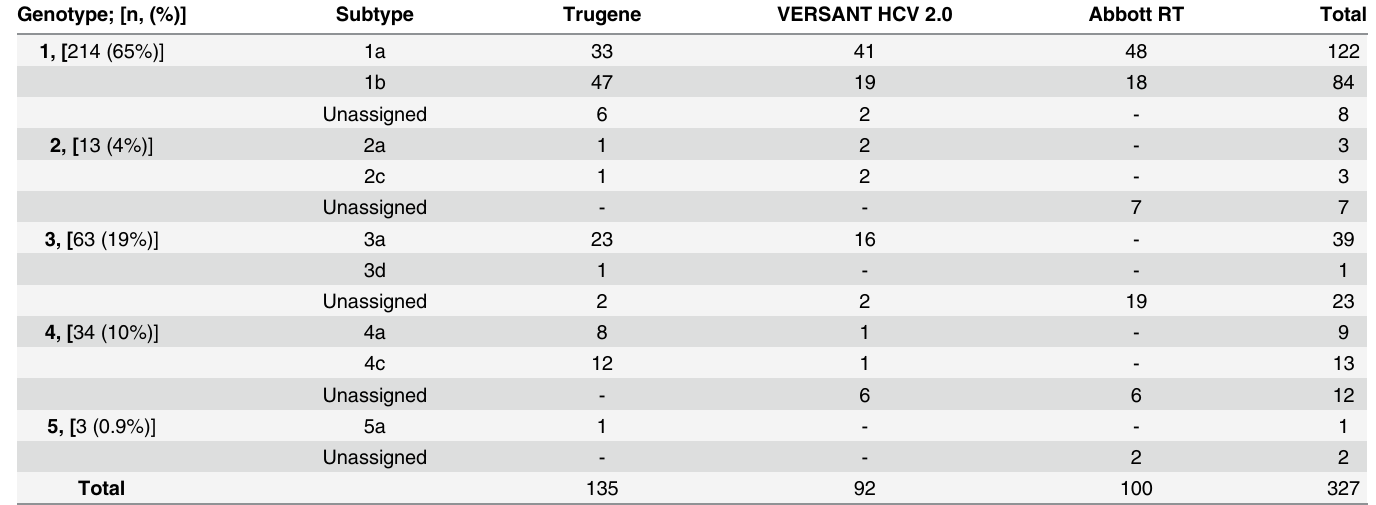
Table 1. Pre-screening of the 327 samples included in the study by three commercial assays. Genotype; [n, (%)]